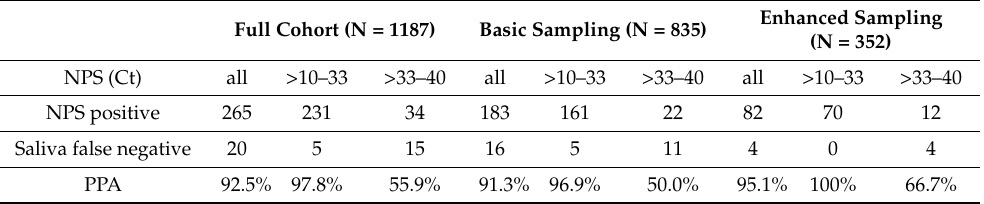
Figure 4. Intensified saliva sampling increases the low level of SARS-COV-2 detection in saliva. E-gene Ct values of paired NPS and saliva samples of the study arm “Basic” (1–2 × saliva per tube; N = 835) and “Enhanced” saliva collection (3 × saliva per tube; N = 435). Red dots = adults; blue triangles = children. Table 3. Positive percent agreement (PPA) stratified by NPS E-gene Ct values and saliva